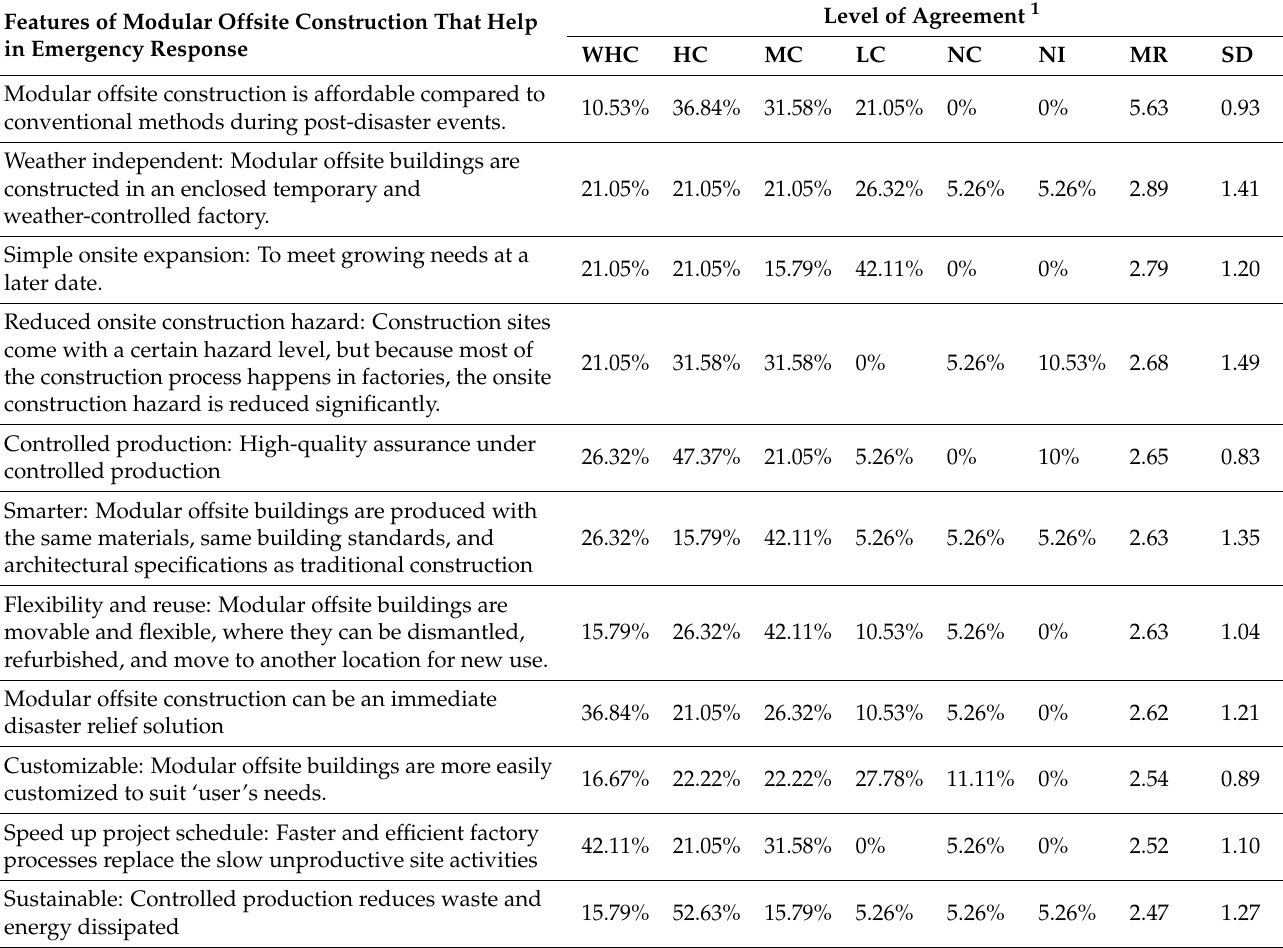
Table 5. Features of modular offsite construction that help in emergency